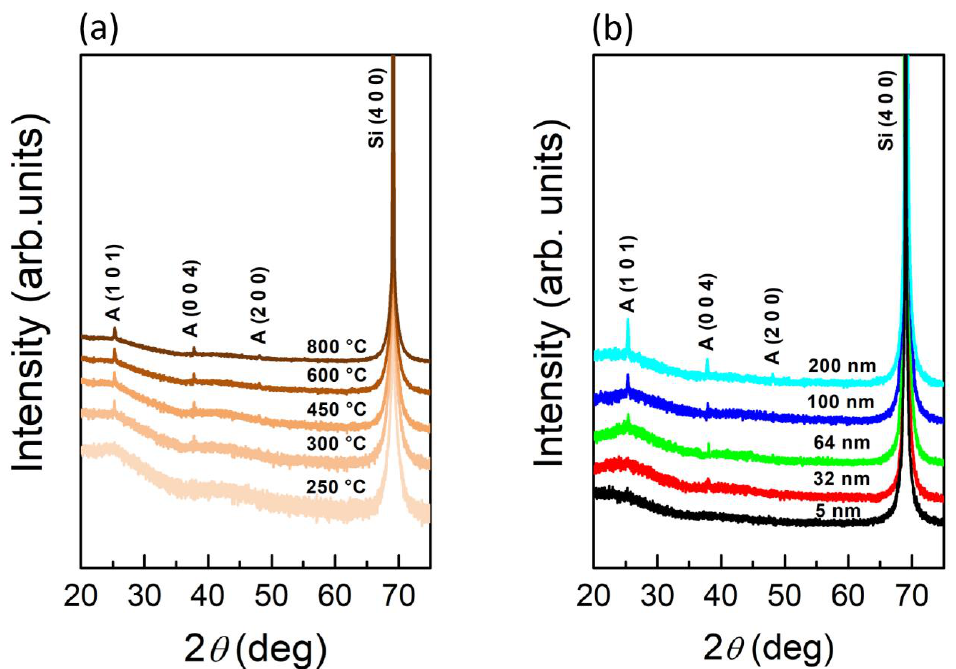
Figure 4. ( a ) XRD spectra of 200 nm TiO 2 samples annealed in air for 12 h at different temperatures; ( b ) XRD spectra of TiO 2 films with a thickness of 5, 32, 64, 100, and 200 nm annealed in air for 12 h at 800 ◦ C. The symbol A indicates the anatase phase.